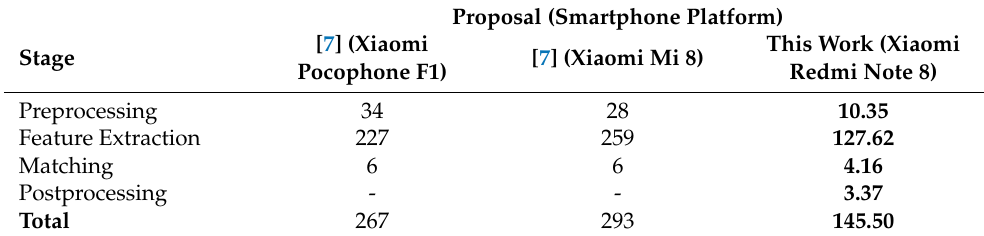
Table 4. Computation times (ms) for the stages of vein recognition based on SIFT.